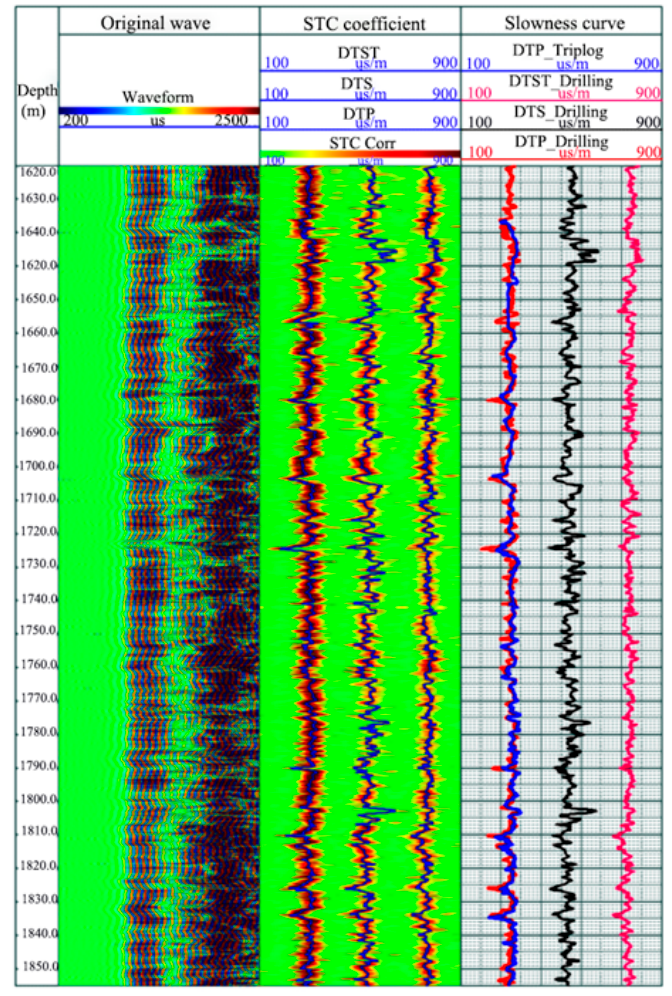
Figure 18. Comparison of LWD and wireline logging results in the X ‐ 2 well.